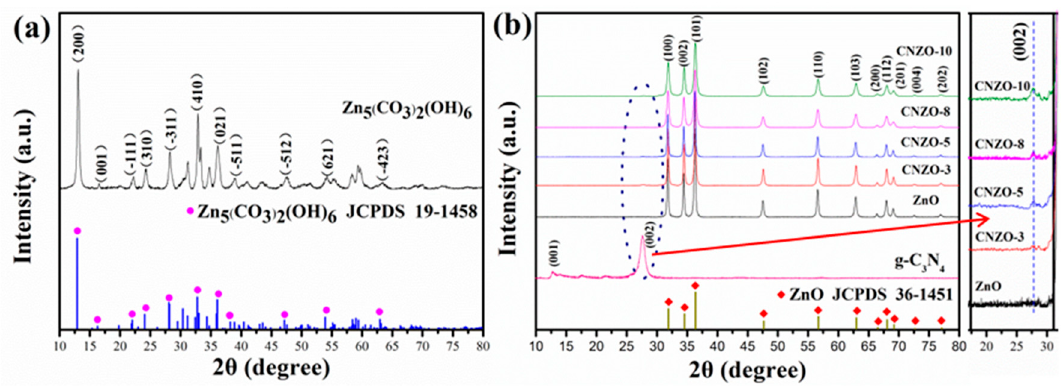
Figure 3. XRD patterns of the as-prepared ( a ) Zn 5 (CO 3 ) 2 (OH) 6 , ( b ) g-C 3 N 4 , ZnO, CNZO-3, CNZO-5, CNZO-8, and CNZO-10.